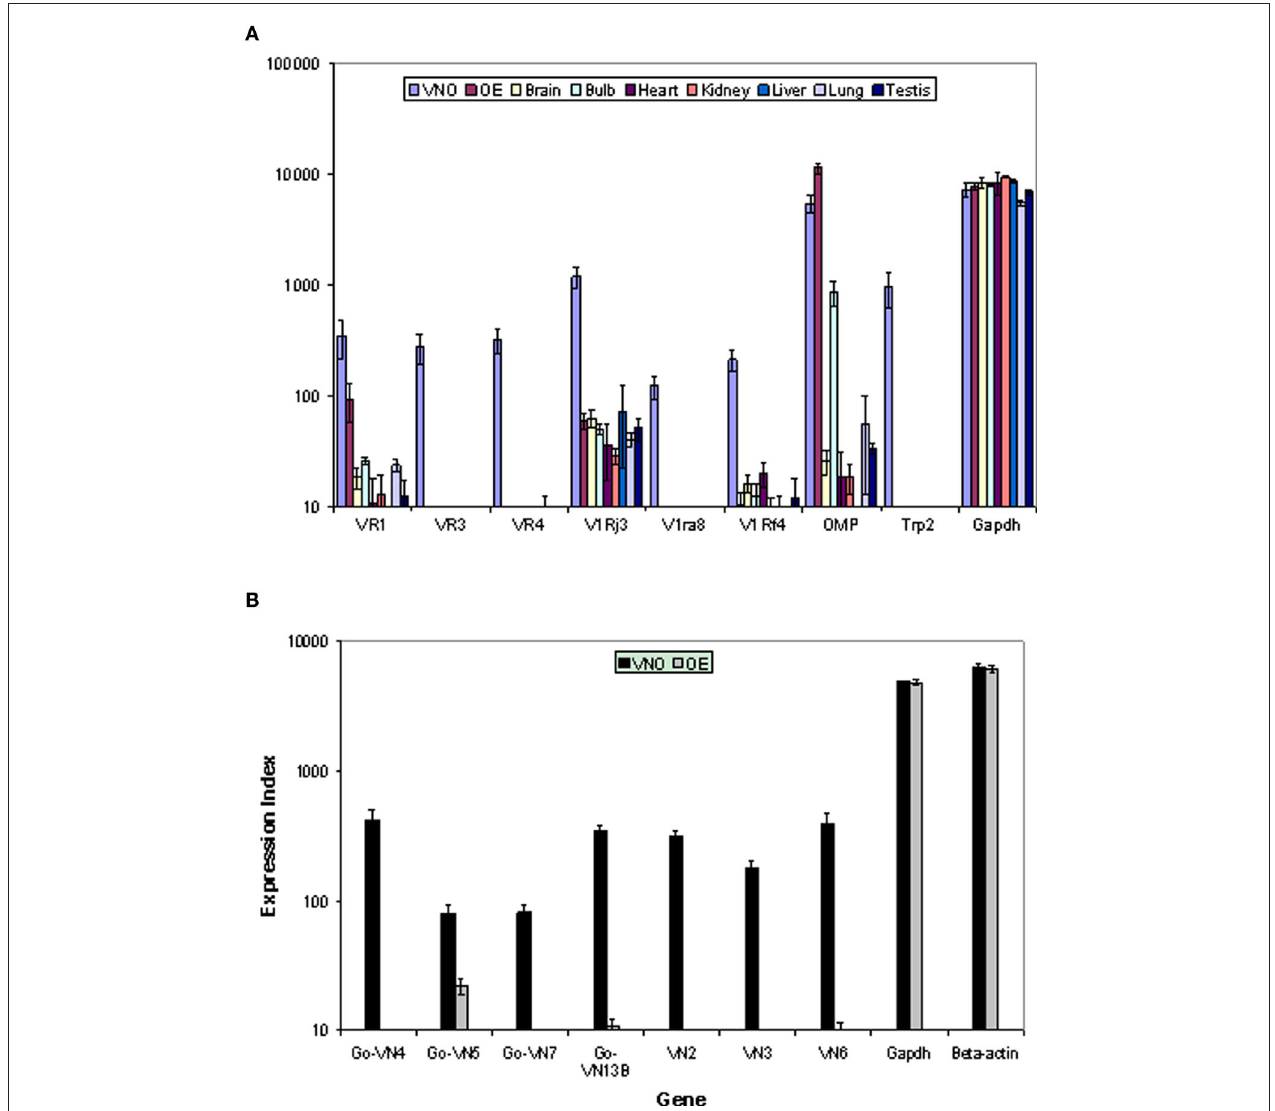
VNO, n = 3 for other tissues. Control genes show expression profiles consistent with known data. Receptor genes show clear differential expression in the appropriate olfactory tissue despite the relatively low signal